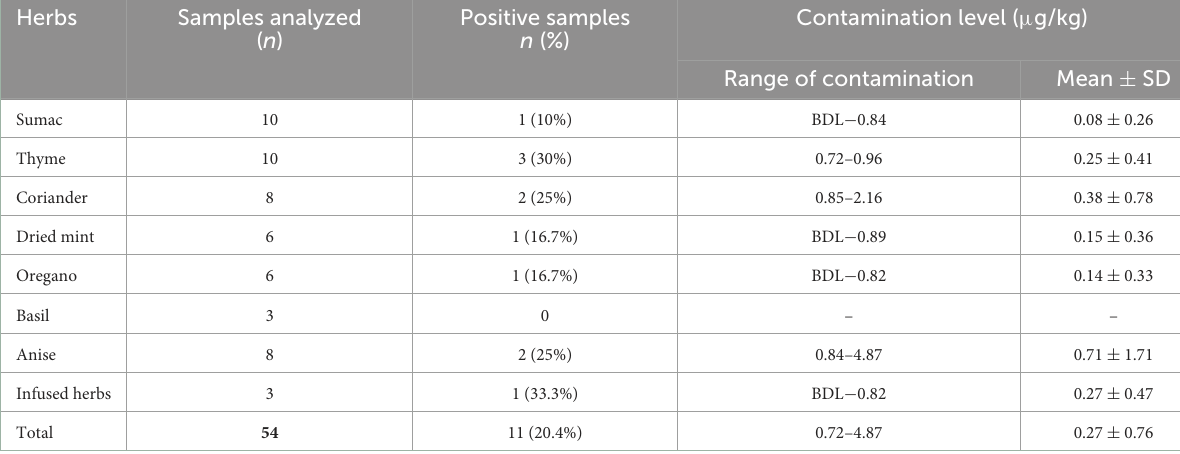
TABLE 3 Incidence and occurrence of AFB 1 in different kinds of herbs in Lebanon. Herbs